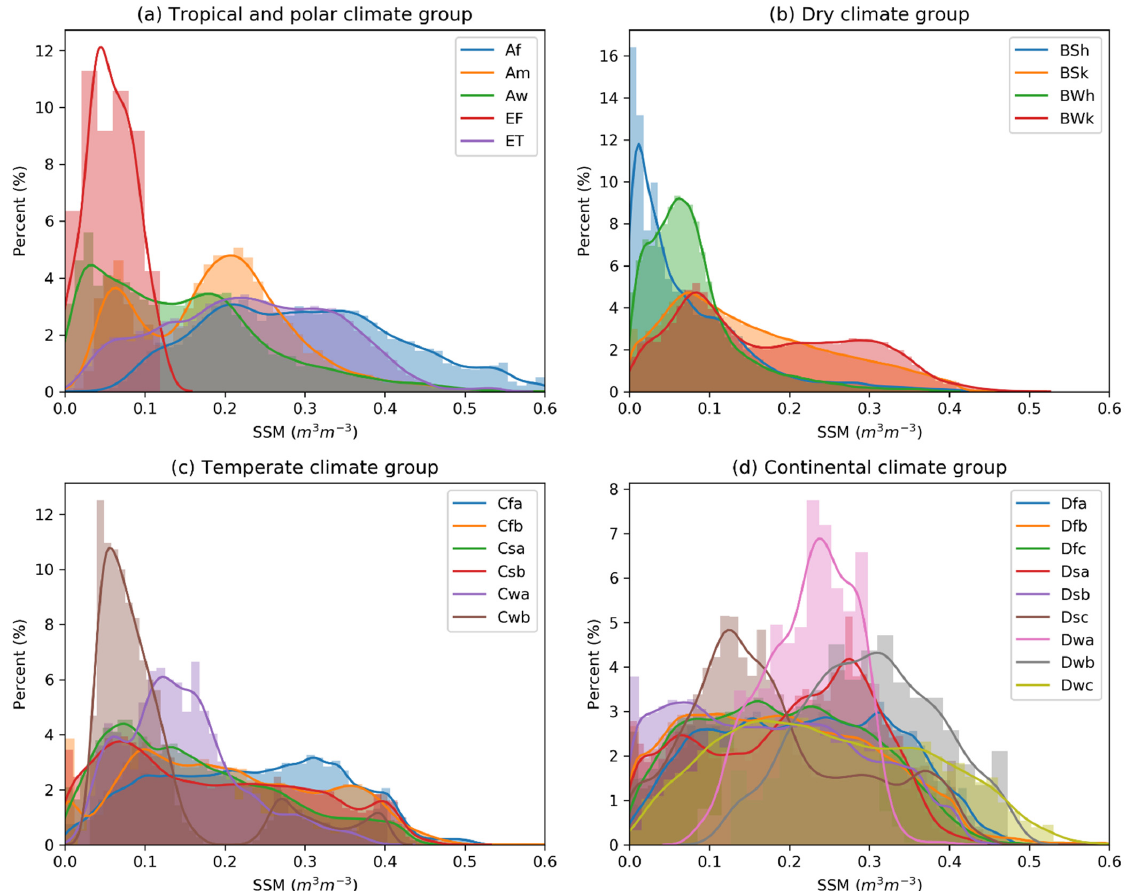
Figure 12. Frequency distribution of in situ SSM over various climate zones at the global scale.